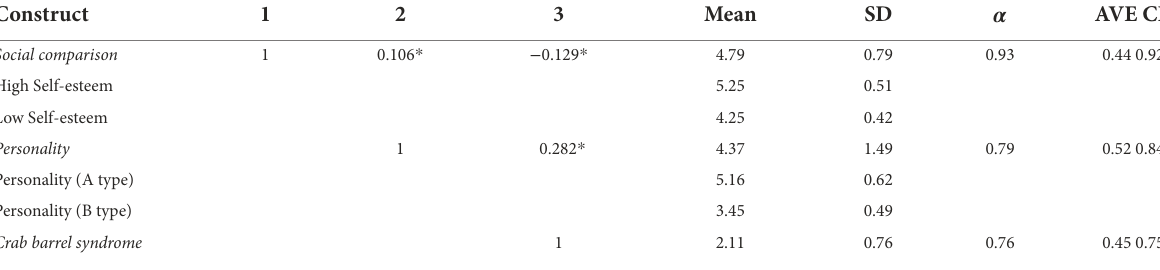
TABLE 1 Correlations among variables, mean, standard deviations, and